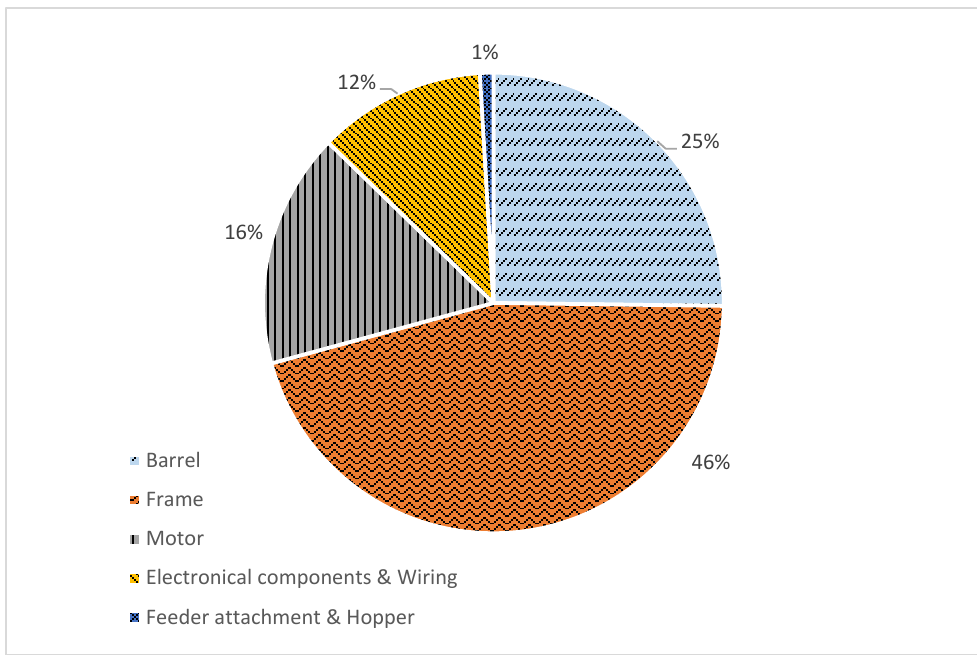
Figure 1. The percentage of the minimum embodied energy of each major component class in a recyclebot.